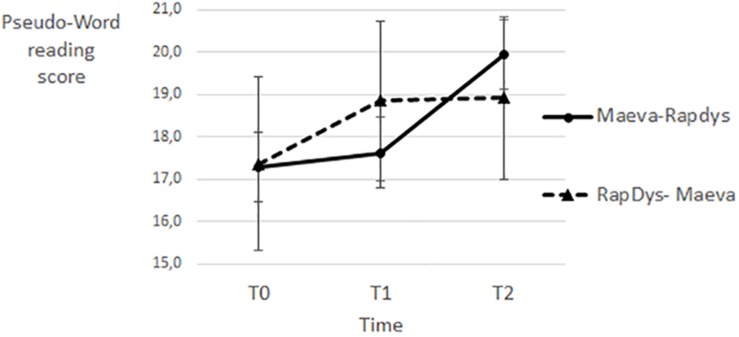
Pseudo-word word reading scores for each time period and each presentation order.